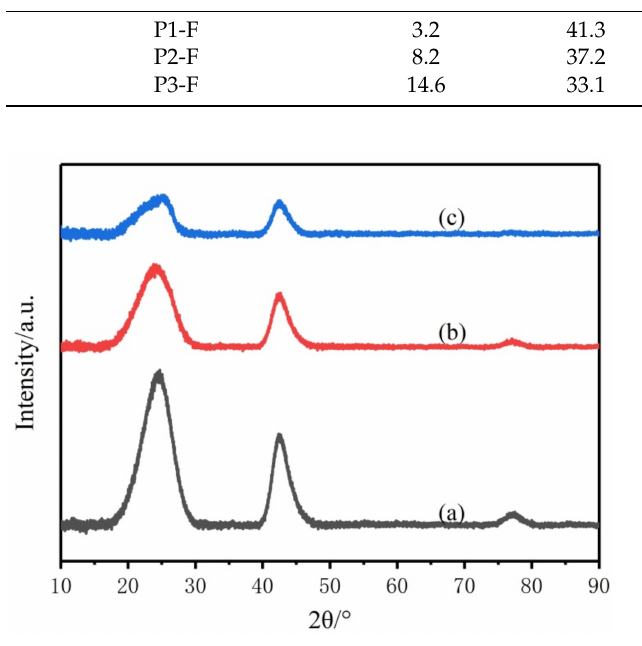
Figure 5. XRD patterns of the composite ceramic fibers: ( a ) P1-F; ( b ) P2-F; ( c )